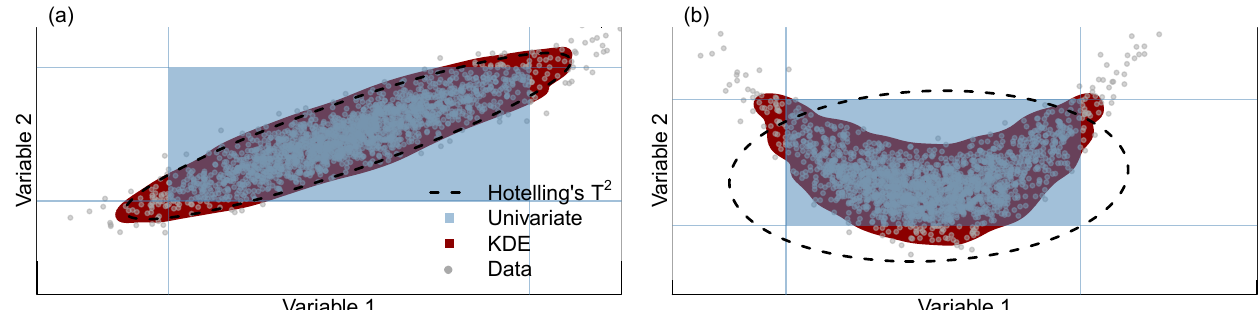
Figure 3. Illustration of the multivariate anomaly detection algorithm with two variables. The data have (a) linear dependencies (multivariate normal) and (b) a nonlinear dependency structure. Univariate extreme event detection (peak-over-threshold in the marginal distribution of a variable) does not follow the shape of the data, whereas algorithms assuming a multivariate normal distribution (Hotelling’s T 2 , Lowry and Woodall, 1992) are suitable for case (a) ; kernel density estimation (KDE) gets the shape of the data in both cases (a) and (b) ; 5% extreme anomalies are outside the shaded areas (region of “normality”) for all three algorithms.